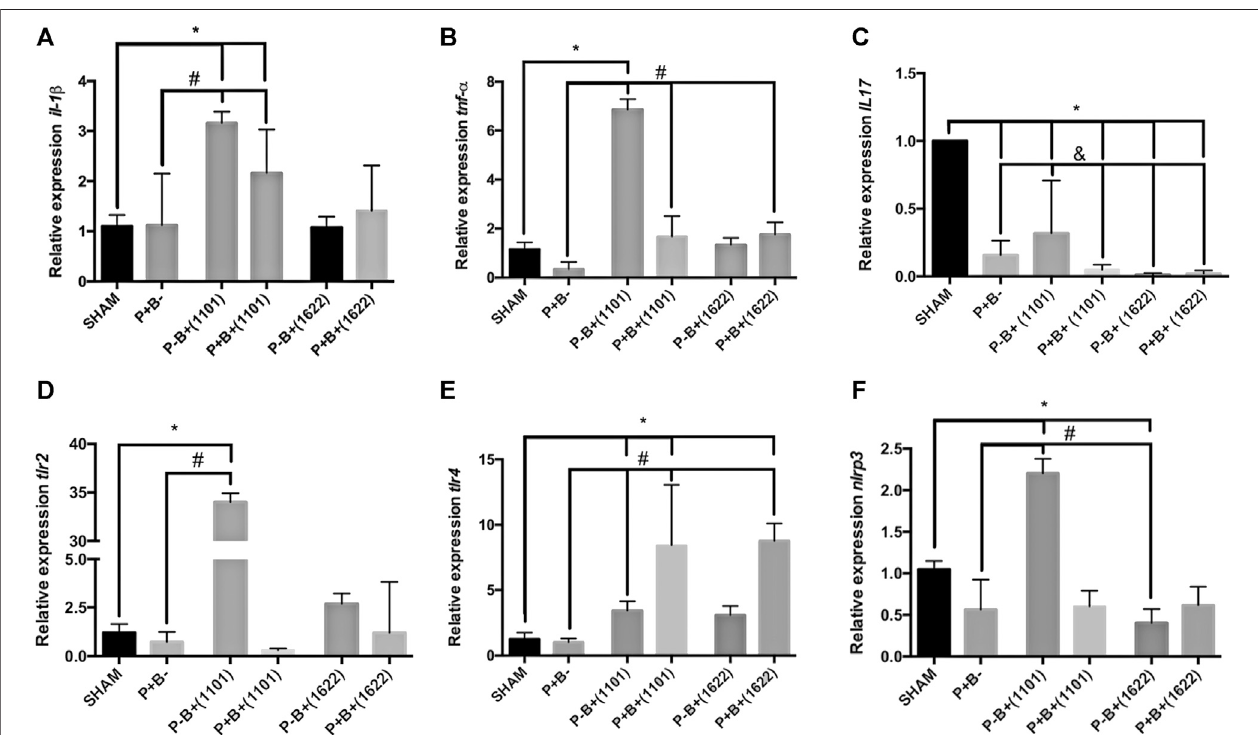
FIGURE 3 | Bi fi dobacteria alter transcription of genes encoding cytokines and receptors for PAMPS in gingival tissues. Relative transcription of Il-1 β (A) and Tnf- α (B) , Il-17 (C) , Tlr2 (D) , Tlr4 (E) and Nrlp3 (F) , determined by RT-qPCR in gingival tissues of C57Bl/6 mice submitted to different treatments for 45 days of experimental period:SHAM(negativecontrol), P+B-(positive control), P-B+(1101) ( B.breve 110 1A ),P+ B+(1101) (microbial consortium + B. breve 110 1A ),P-B+ (1622) ( B. bi fi dum 162 2A ) and P + B+ (1622) (microbial consortium + B. bi fi dum 162 2A ). * Statistically signi fi cant difference in relation to negative control (SHAM), # Statistically signi fi cantdifferenceinrelationtopositivecontrol(P+B-).&Statisticallysigni fi cantdifferenceinrelationtoP-B+(1101).ANOVA,Tukey ’ smultiplecomparison, p < 0.05%. Data representative of two independent experiments ( n (cid:1) 8 mice/per